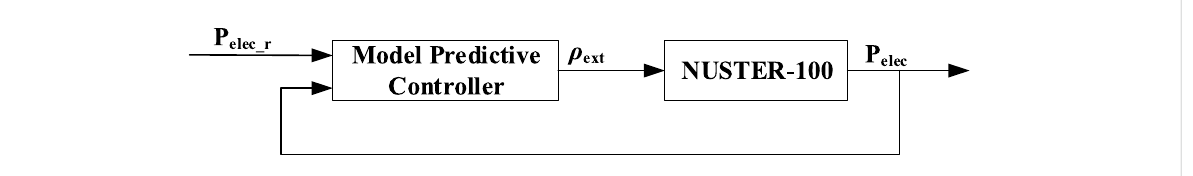
FIGURE 6 NUSTER-100 electric power control system.